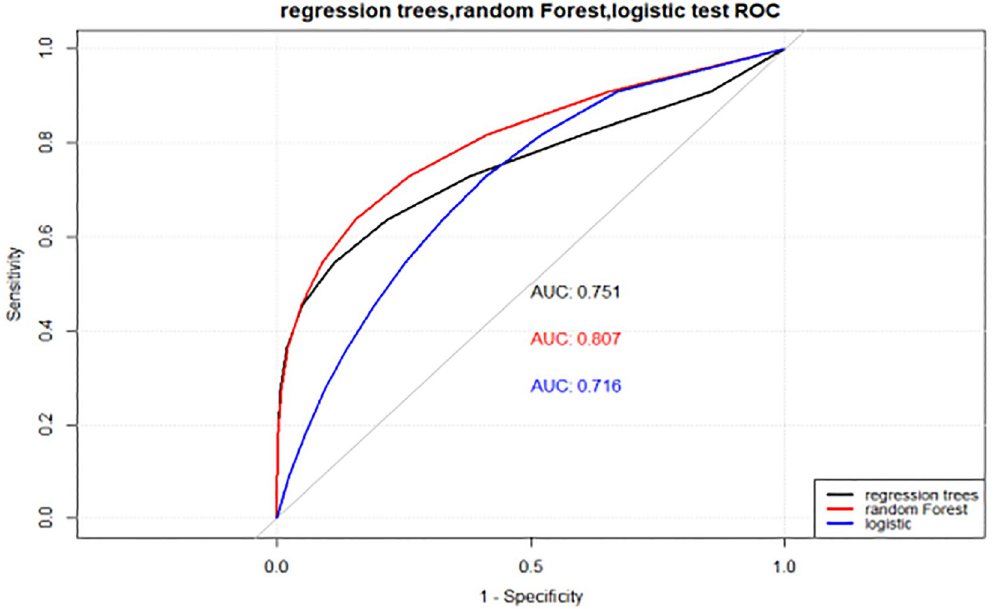
Fig 4. ROC curves of logistic, decision tree and random forest models in the test